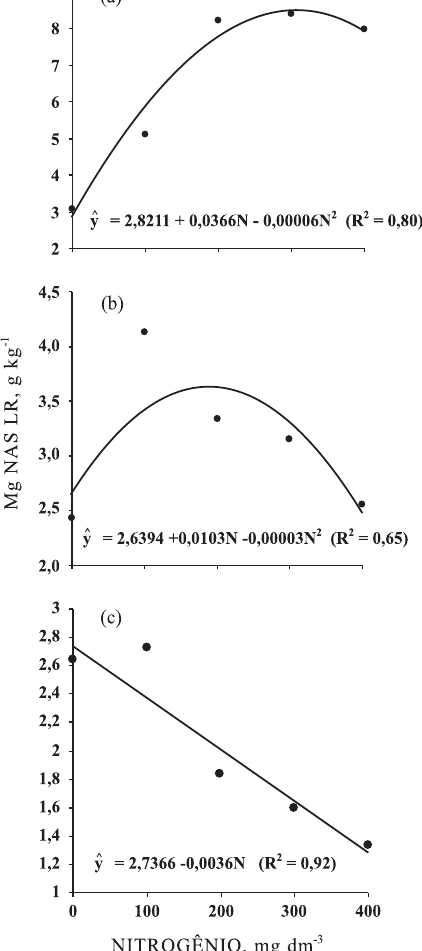
Figura 3. Teor de magnésio nas lâminas de folhas recém-expandidas (LR) do capim-marandu, no primeiro (a), segundo (b) e terceiro (c) cortes, em função das doses de